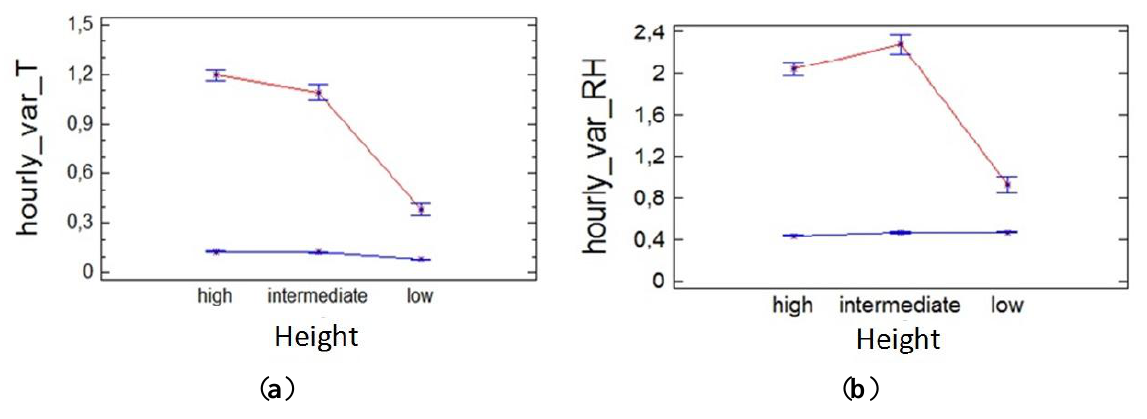
Figure 8. Interaction plot of the factors climate control system (blue = OFF, red = ON) and height, for the ANOVA analysis of the hourly variation of ( a ) temperature, ( b ) RH.